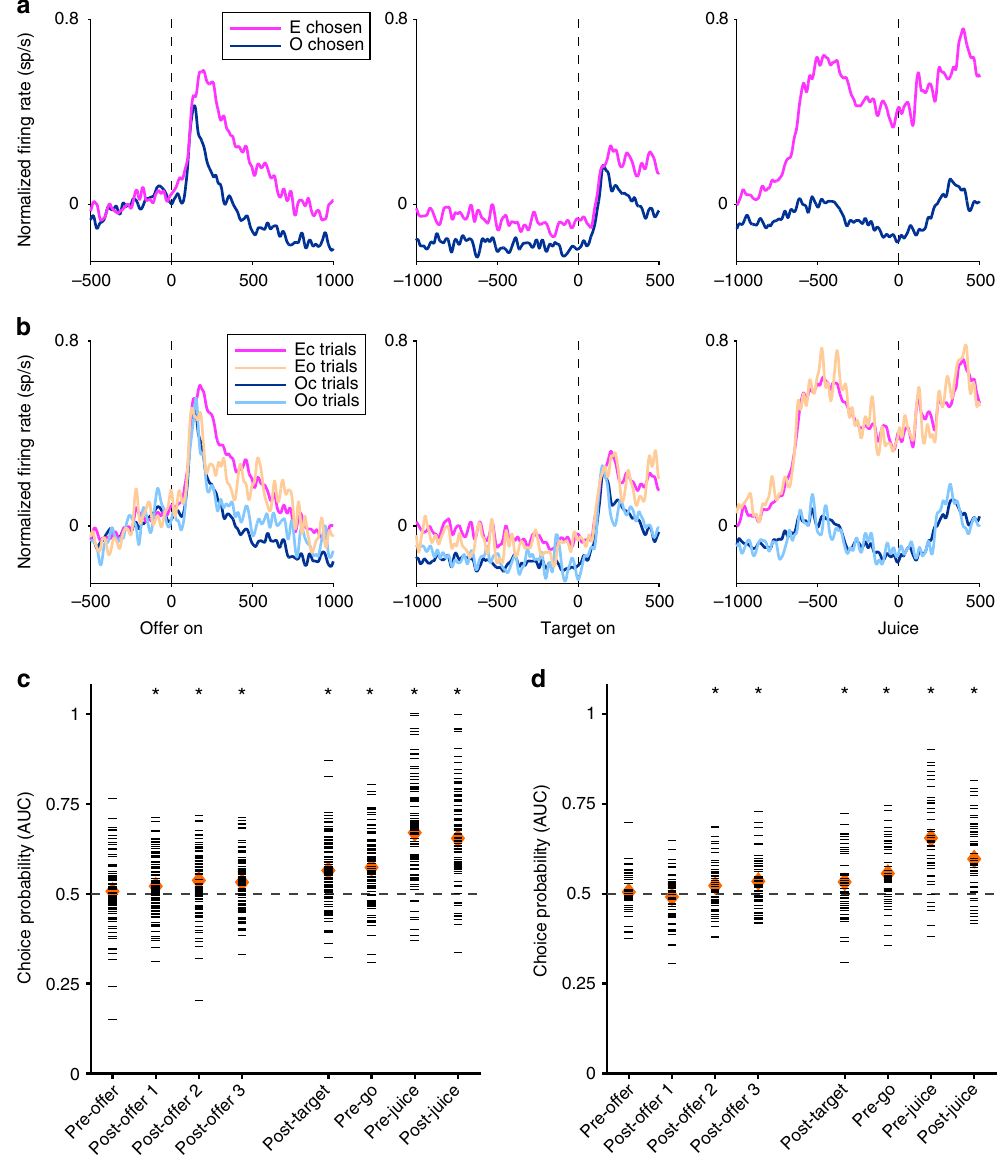
Fig. 6 Population activity pro fi les and ROC analysis for cells encoding the choice outcome. a Chosen juice cells ( N = 108). Neurons were classi fi ed across all time windows. Activity pro fi les were aligned at offer on (left panel), target on (center panel), and juice delivery (right panel). Trials were divided depending on whether the animal chose the juice encoded by the cell (E) or the other juice (O). The two traces clearly separated within 250 ms after the offer. b Chosen juice cells ( N = 97). Trials were divided depending on whether the animal chose the juice encoded by the cell (E) or the other juice (O) and on whether the effect of different action costs was covert (c) or overt (o). Average traces shown here are from the cells for which we could compute all four traces ( ≥ 2 trials per trace). Notably, the activity pro fi le in Eo trials is elevated compared with that in Oo trials. c ROC analysis for 97 chosen juice cells in cost-overt trials (same population as in b ). Each horizontal gray line represents one neuronal response. Each orange diamond represents the mean AUC, which was signi fi cantly> 0.5 in each of three non-overlapping time windows before target presentation (post-offer 1, mean(AUC) = 0.521, p < 0.02; post- offer 2, mean(AUC) = 0.537, p < 0.0005; post-offer 3, mean(AUC) = 0.532, p < 0.0005; t test; see Methods). d ROC analysis for 51 chosen cost cells in cost-overt trials. Same convention as in c . Across the population, mean(AUC) was signi fi cantly p > 0.5 in two of three time windows before target presentation (post-offer 2 (mean(AUC) = 0.522, p < 0.05); post-offer 3 (mean(AUC) = 0.534, p < 0.002; t test). c and d , an asterisk (*) indicates p < 0.02,